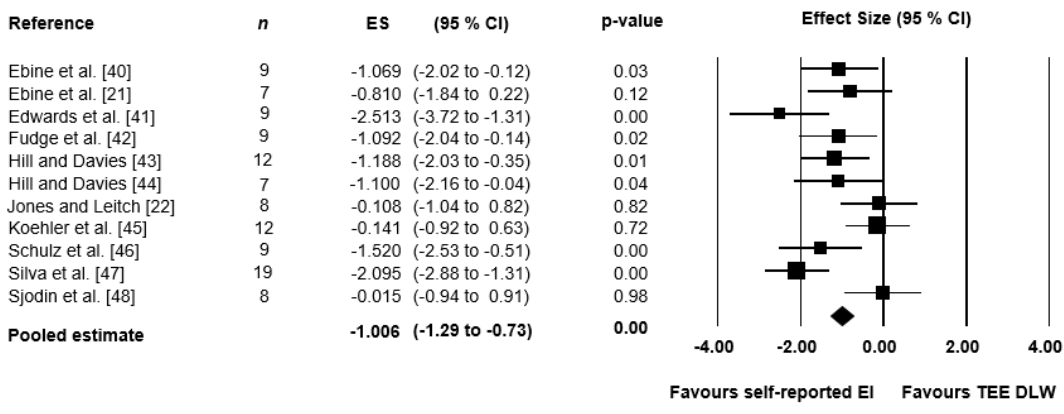
Figure 3. Meta-analysis of the pooled effect of self-reported EI when compared to TEE measured by DLW.